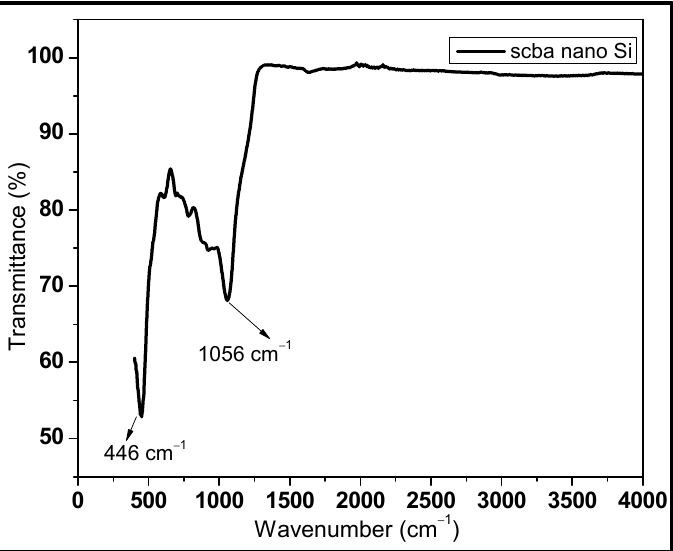
Figure 2. FTIR spectrum showing surface chemistry of SCBA nano silicon.